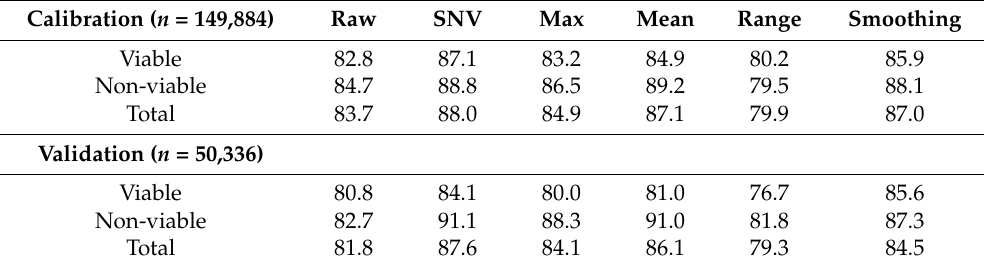
Figure 6. ( a ) VIP score plot indicating the key wavelengths selected for model development with original raw spectrum and ( b ) indicate average spectrum data and selected wavelength with each pretreatment methods (yellow bar is common key wavelength). Table 3. Calibration and validation results on pixels (in percent) of PLS-DA VIP model with selected wavelengths.